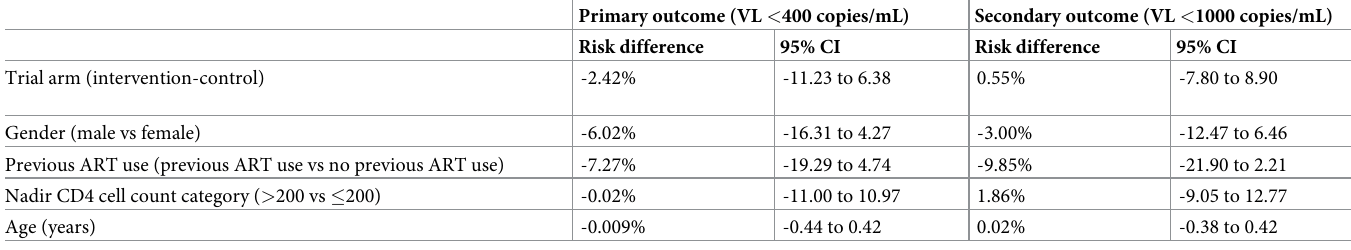
Table 3. Results of additive binomial model examining the association between trial arm and primary outcome (VL < 400 copies/mL) and secondary outcome (VL < 1000 copies/mL) adjusted for demographic and clinical characteristics (n =